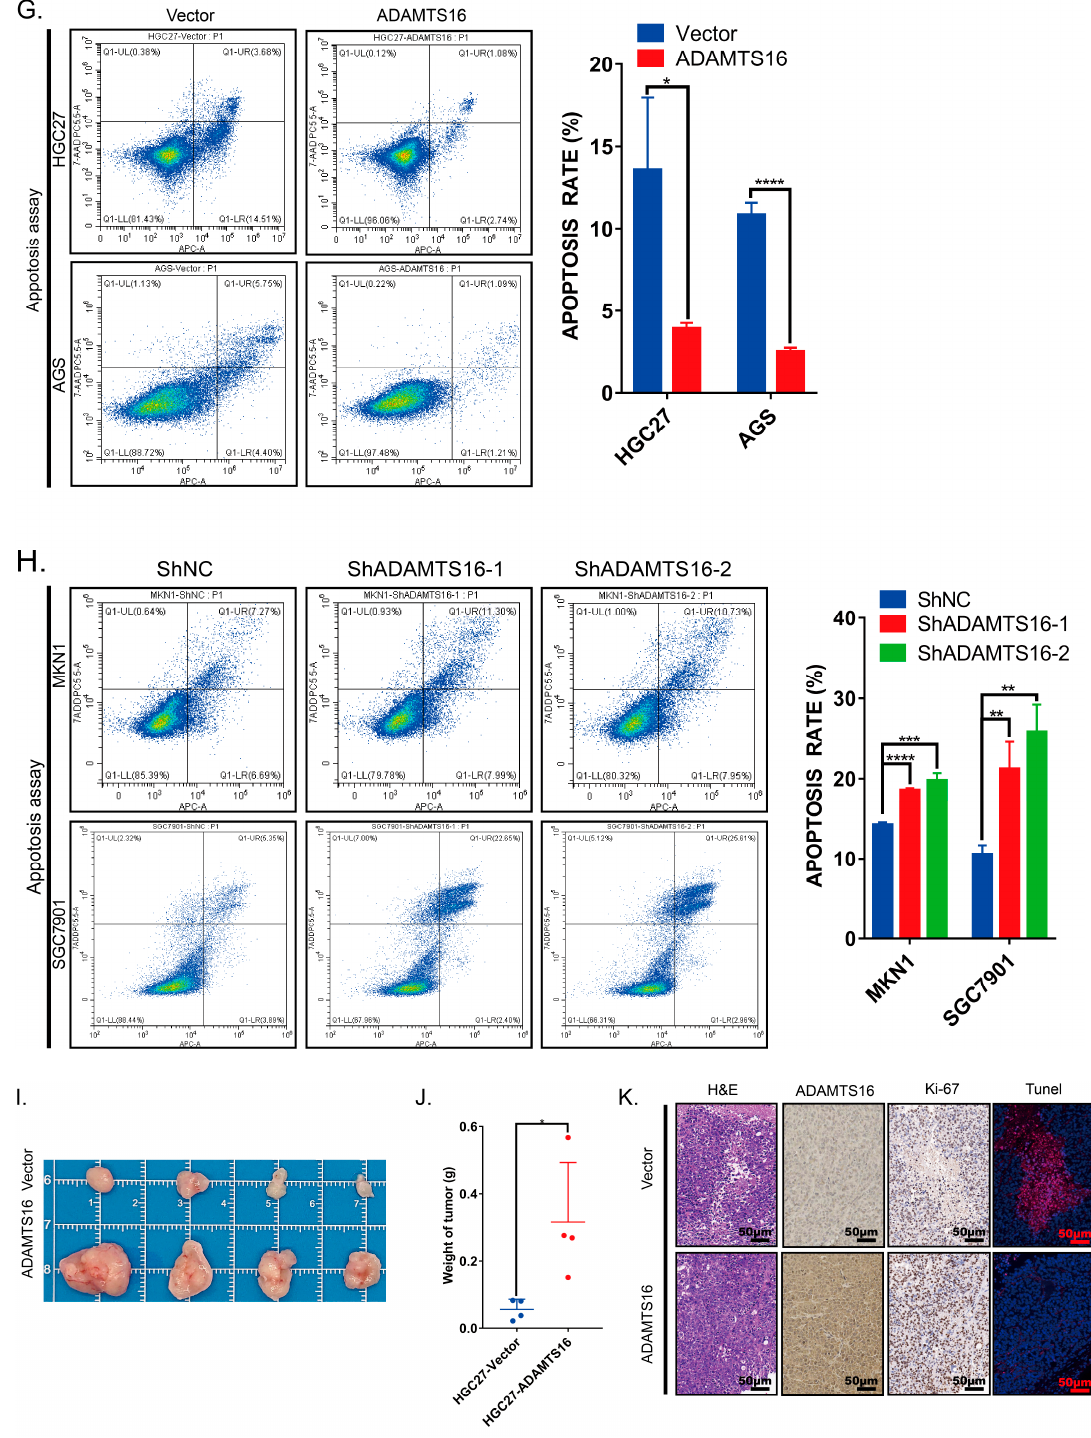
Figure 2. Effects of ADAMTS16 expression on GC cell and growth in vitro and in vivo. ( A – D ). Representative colony formation assay images and quantitative analysis of cell proliferation. ( E , F ) Flow cytometry showed that ADAMTS16 expression in GC cell lines induced G2/M phase arrest. ( G , H ) Flow cytometry was used to reveal the effects of ADAMTS16 expression on GC cell apoptosis arrest. ( I – K ) Effect of ADAMTS16 expression on tumor growth in nude mice and representative immunohistochemistry images of ADAMTS16, Ki67 and TUNEL in tumor tissues. Scale bar, 50 µm. The data are shown as means ± standard deviations. * p < 0.05, ** p < 0.01, *** p < 0.001, **** p < 0.0001. ns, not significant.